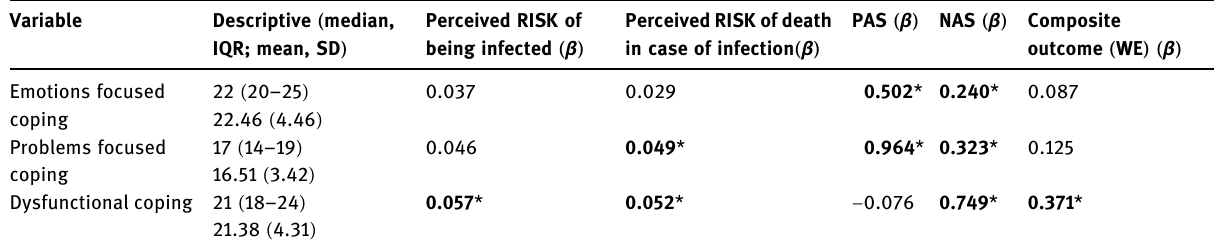
Table 3: Coping strategies in the entire population and generalized linear model regression coe ffi cients ( β )